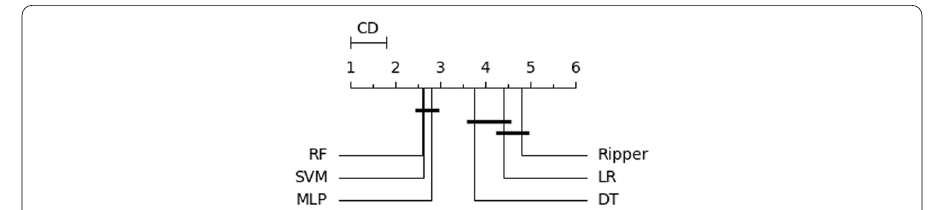
Fig. 3 Critical difference diagram of the comparison of classifiers. Models that are not connected with a bold line have a significant difference in performance (at a 5% level with the Nemenyi